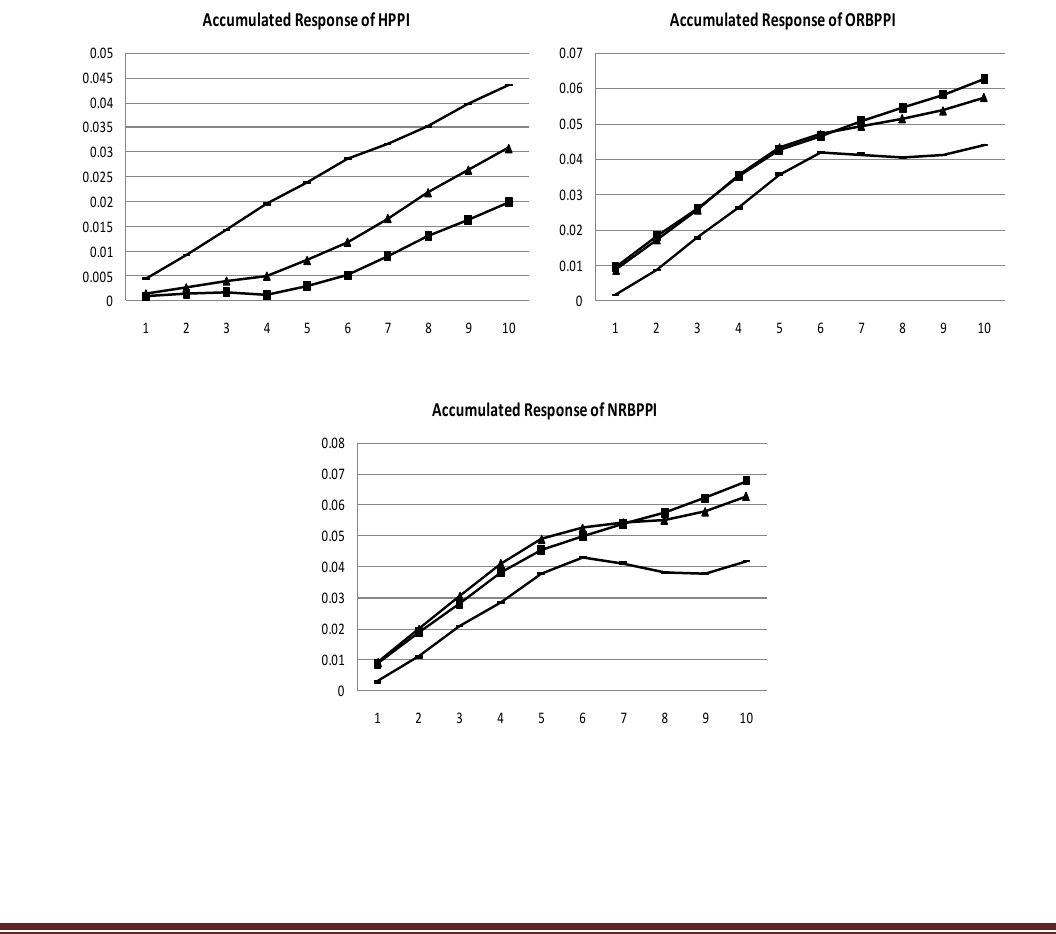
Liu, J and London, K A (2010) ‘Convergence among the sub-markets in Australian regional building construction sector’ , Australasian Journal of Construction Economics and Building, 10 (4)